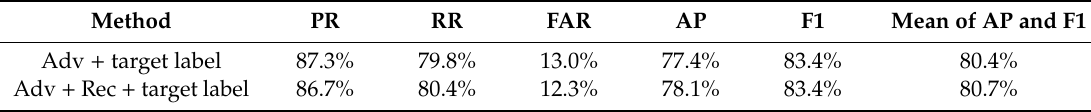
Table 4. Detection performance of each method with Dataset